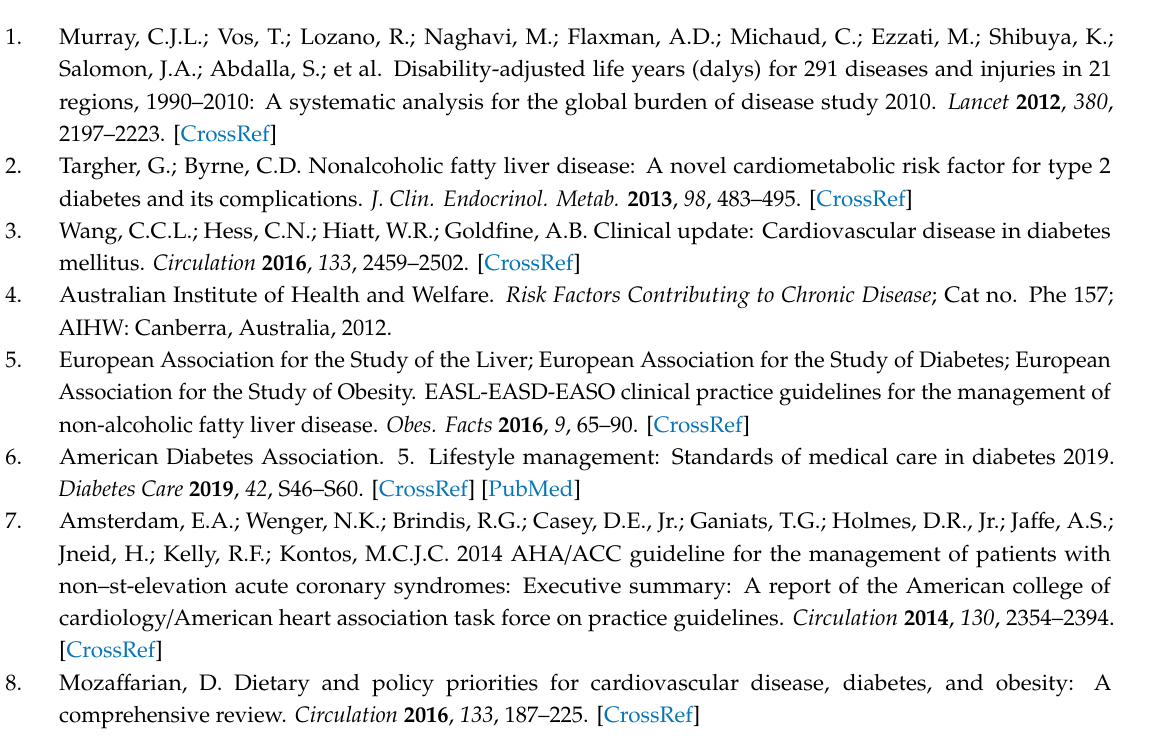
Table S1: Dietitian participants Australian State or Territory of work, Table S2: Statistical comparisons between how often dietitians counsel chronic disease populations on Mediterranean dietary pattern and characteristics of their relevant practice, Table S3: Statistical comparisons between dietitians perceived knowledge, confidence to counsel and role regarding Mediterranean dietary pattern (MDP) and characteristics of their relevant practice, Document S1: National Survey questions including conditional release